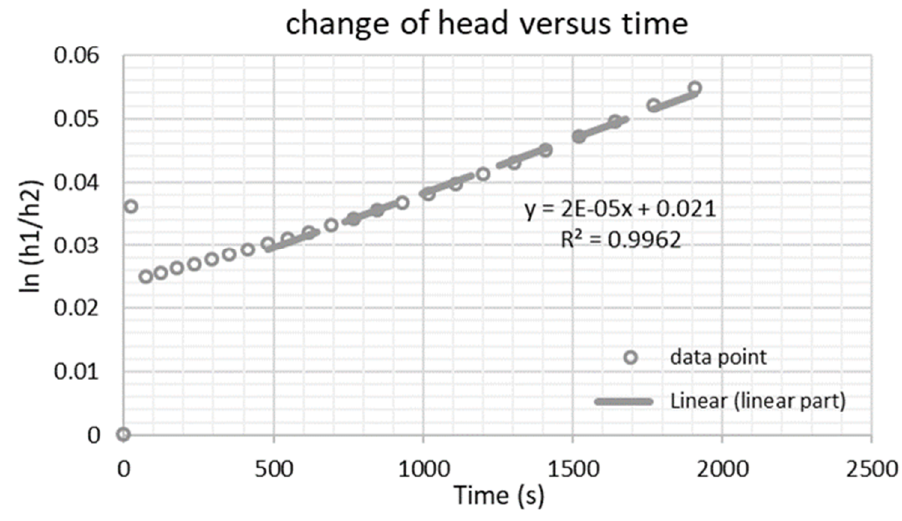
Figure 6. Change of head versus time during falling head permeability test.